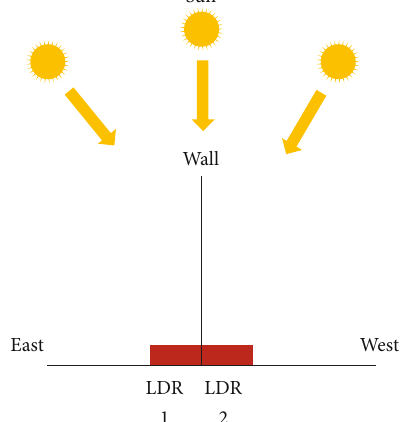
Figure 27: The diagram of the proposed solar collector.